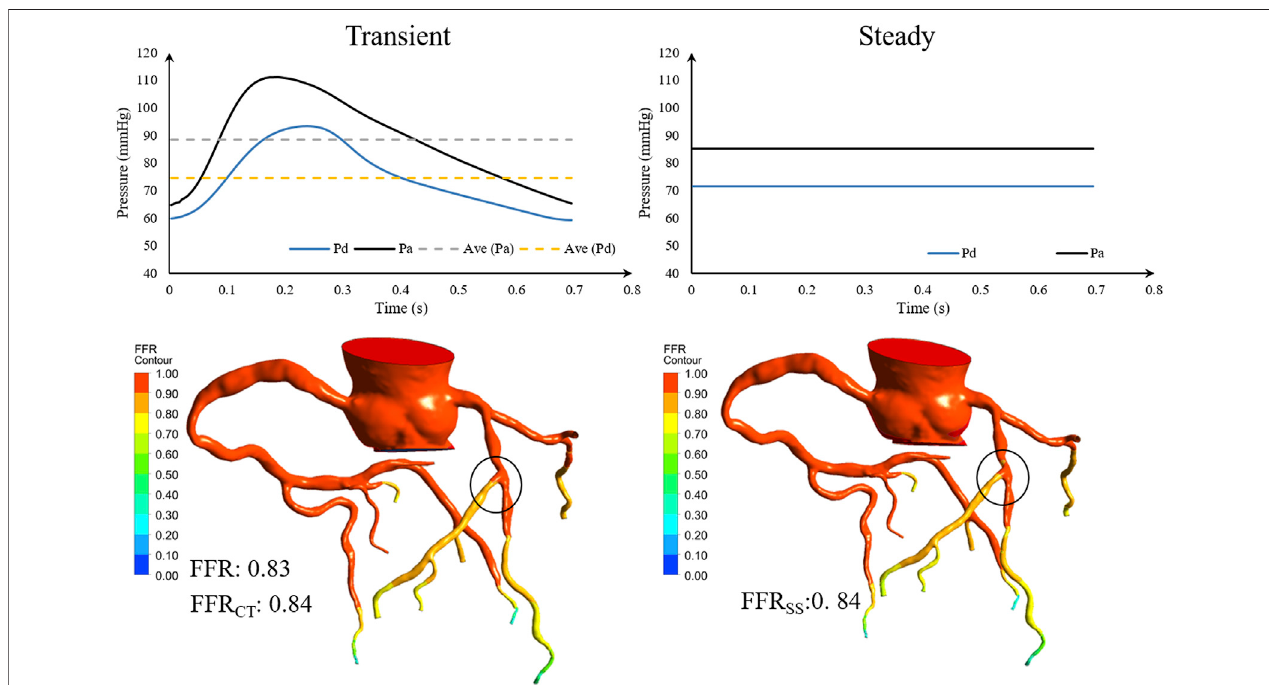
FIGURE 7 | Geometric multiscale solution for comparison of transient and steady-state pressure. Pa is the inlet pressure of the stenotic vessel, Pd is the outlet pressure, and Ave is the mean pressure.